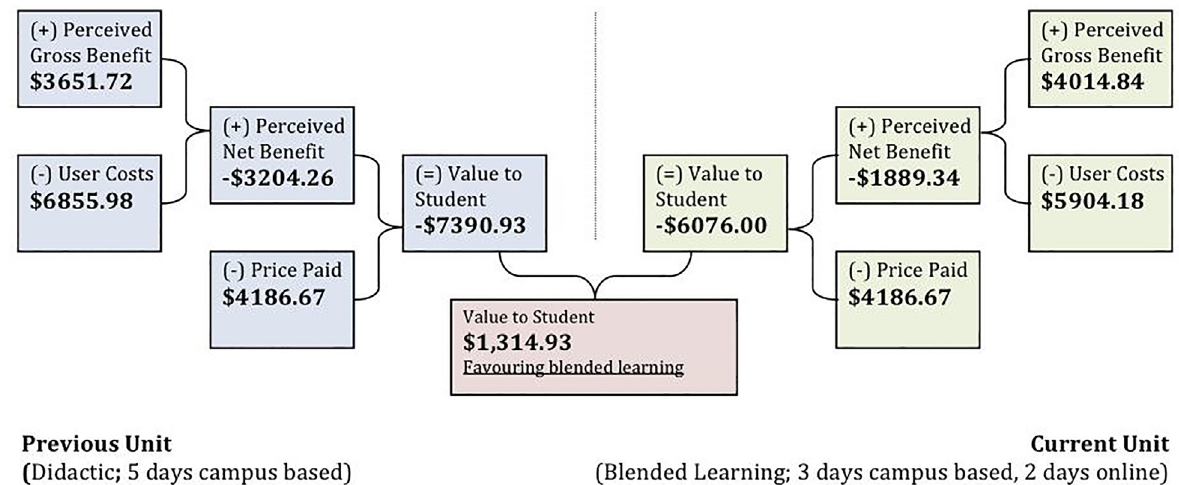
Fig 2. Summary of Mean Value to Student.